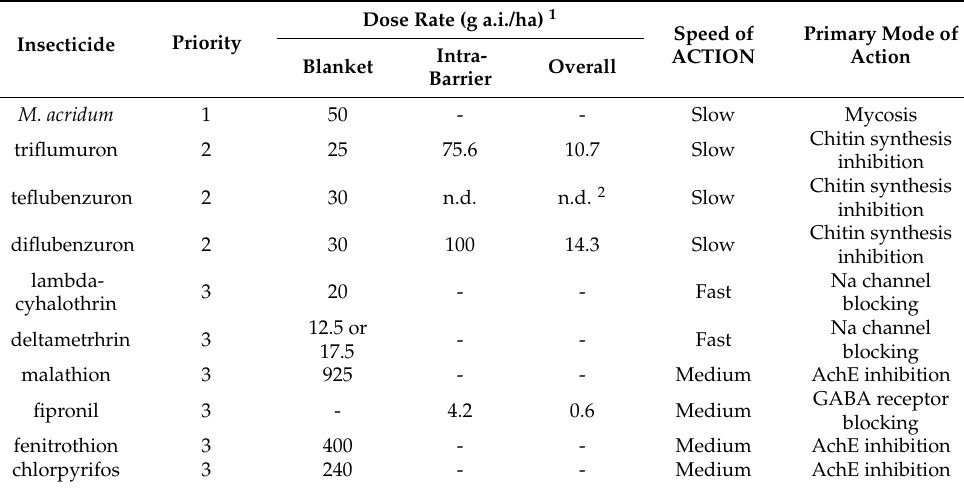
Table 1. Verified dose rates of insecticides for DL control. Adapted and simplified from Tables 2a and 7 in LPRG [13]. Blanket dose rates are for both adults and